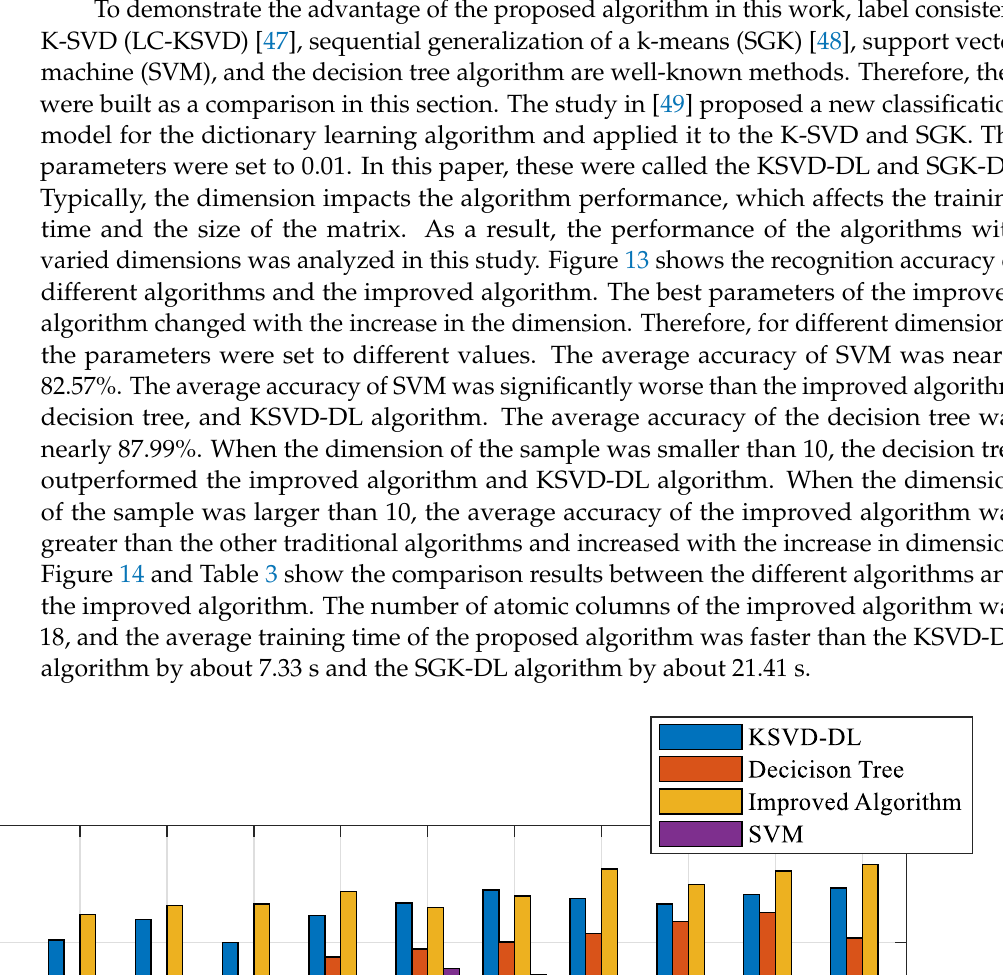
Figure 14. The training time of the traditional algorithm and improved algorithm. Table 3. The comparison of the improved method with other methods (sample dimension M = 24). Algorithm LC-KSVD